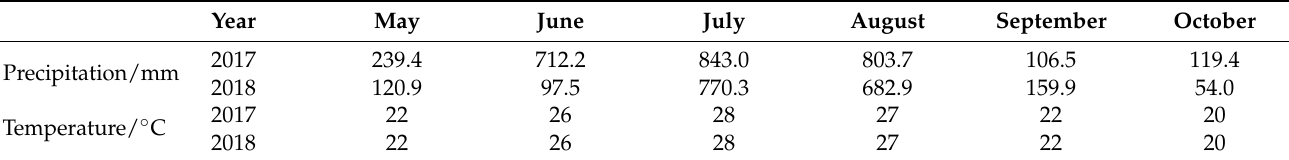
Table 1. Average temperatures and rainfall during cotton growing season